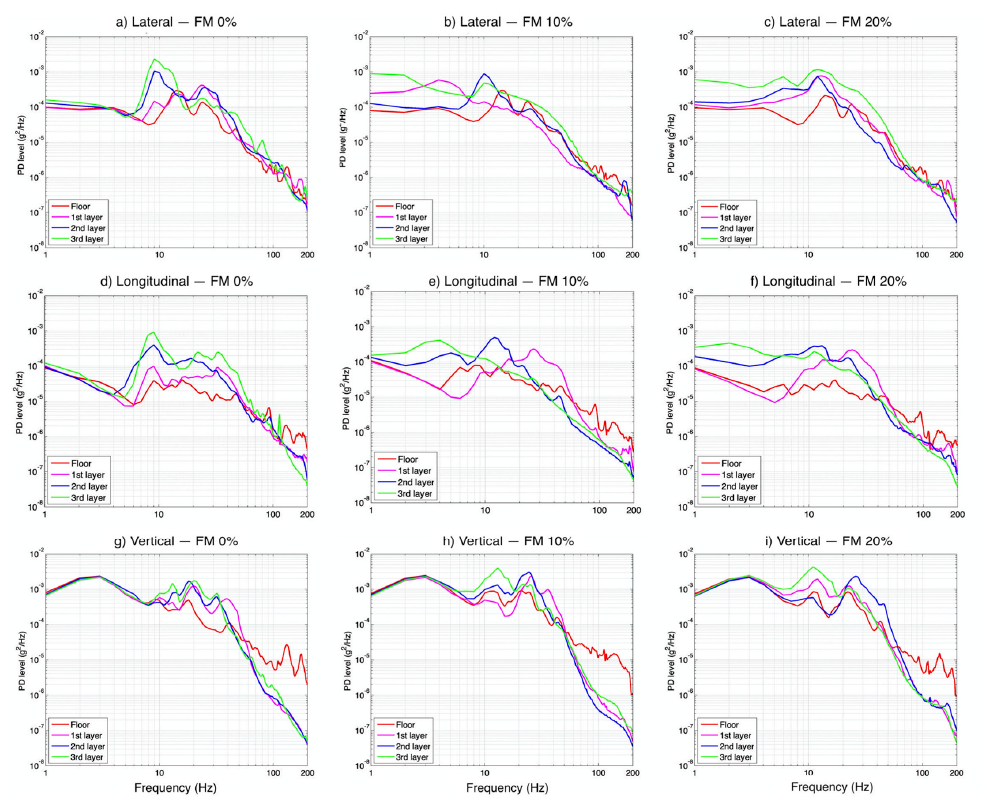
Figure 6. PSD plots of various layers in a stacked unit and on the floor at FM 0%, 10%, and 20%, in the ( a – c ) longitudinal, ( d – f ) lateral, and ( g – i ) vertical axes.